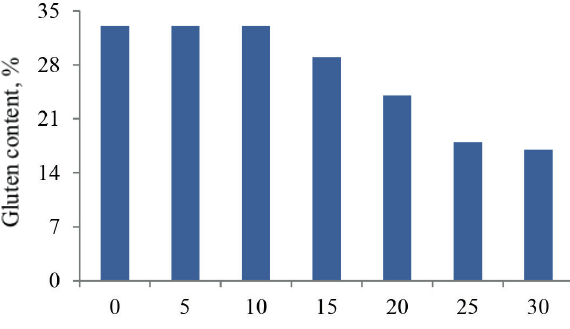
Figure 6 Gluten content in the model mixtures of wheat flour and amaranth extrudate